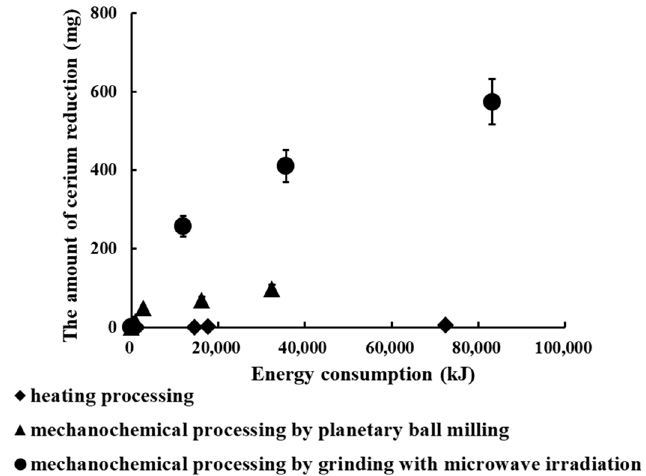
Figure 6. Relationship between energy consumption and the amount of cerium reduction.